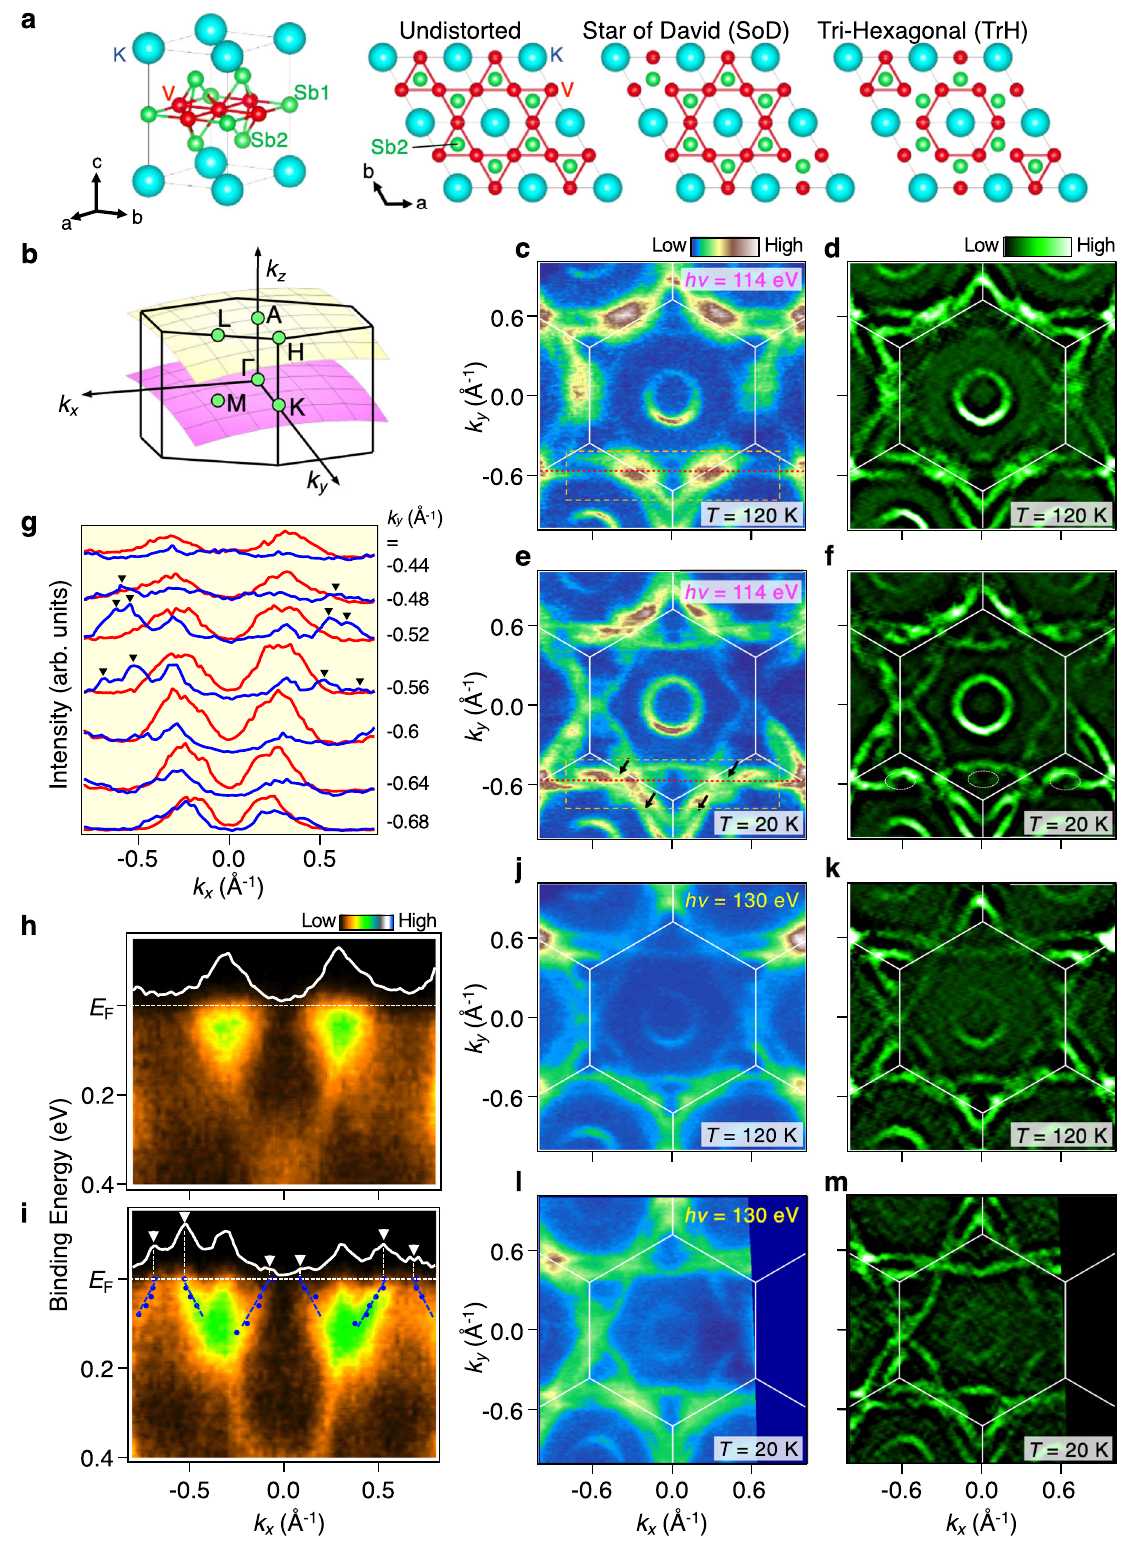
(cid:1) Γ (Fig. 1c) as seen in the existence of a circular pocket at the point (cid:1) k π by using h ν = and triangular FSs at the K point, the bright intensity around z ~ the M point seen at k z = 0 (Fig. 1c) is absent at k z ~ π (Fig. 1j). This is because the saddle-point band is located well above E F at k π 29,35,37,43 due to the k fl uence z ~ z dispersion. To see the in